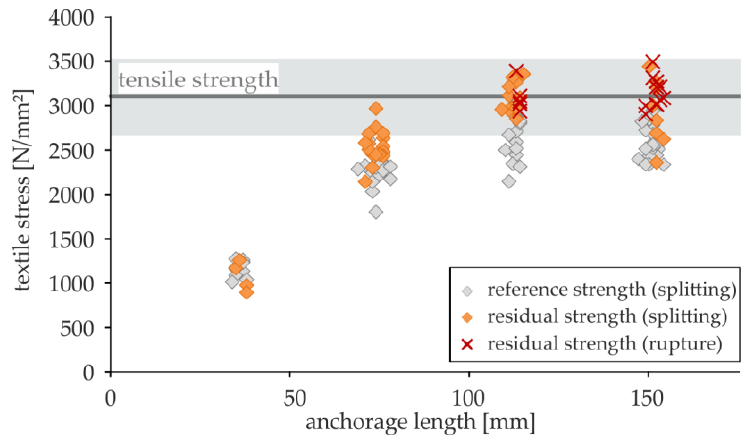
Figure 16. Comparison of textile stresses and failure mechanisms in reference and residual strength tests with different anchorage lengths.